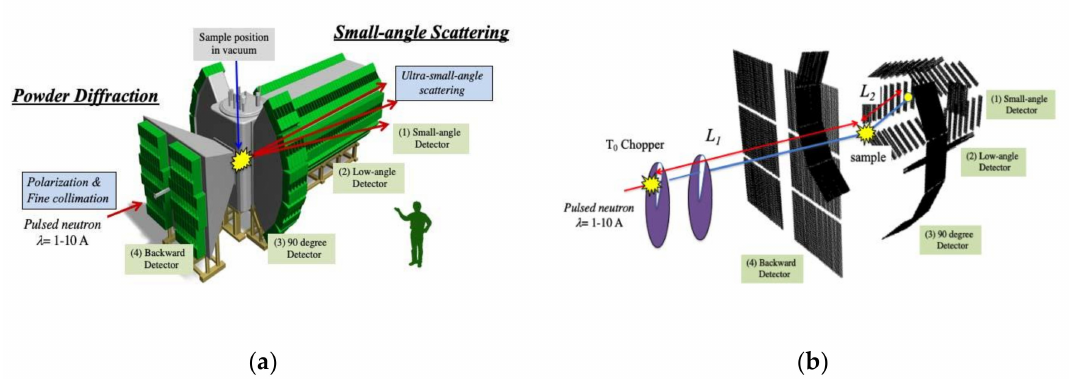
Figure 3. ( a ) Schematic diagram of the iMATERIA di ff ractometer (BL20) at the Materials and Life Sciences Facility (MLF) at the high-intensity proton accelerator (J-PARC), Tokyo. ( b ) Schematic view of tube detectors of the iMATERIA di ff ractometer, covering the sample position and tube detectors, highlighting the small-angle and low-angle detector